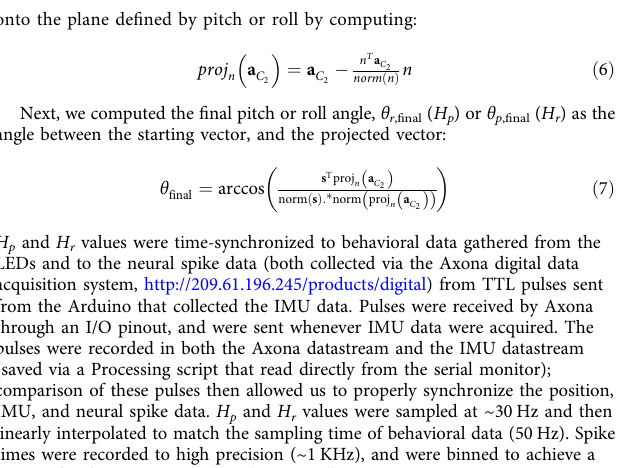
Fig. 8 Tuning to eye position and velocity does not depend on visual information. a On interleaved blocks of trials, mice ( n = 6) ran either on a track with fi ve distinct visual landmarks ( “ With landmarks ” ), or a track of the same length but devoid of visual landmarks ( “ Without landmarks ” ). In both tracks, the fl oor was checkerboard-patterned. b Example traces of E E h and v position as an animal traversed the track without visual landmarks. c Boxplots showing the correlation coef fi cients between cells ’ tuning curves in both tracks. Box, interquartile range; solid line, median; whiskers, range; outliers plotted separately. Correlations were computed for cells signi fi cantly encoding each variable on the landmark track ( n for each variable is shown at top of plots). Position tuning curves were nearly uncorrelated between the tracks (median [1st – 3rd quartile], B = 0.02 [ − 0.19 – 0.25], whereas the tuning curves for cells encoding all eye movement-related variables and body speed were preserved to a signi fi cantly greater extent (median [1st – 3rd quartile ] , B s = 0.82 [0.58 – 0.93], E h = 0.69 [0.13 – 0.88], E v = 0.54 [0.14 – 0.79], _ E h = 0.73 [ 0 . 41 – 0.88], _ E v = 0.40 [0.02 – 0.67]; Χ 2 = 748.27, P = 1.8e-159, df = 5, B versus each other variable, all P < 0.00024, Kruskal – Wallis test followed by post hoc two-sided Wilcoxon rank-sum comparisons with α = 0.0033 after Bonferroni